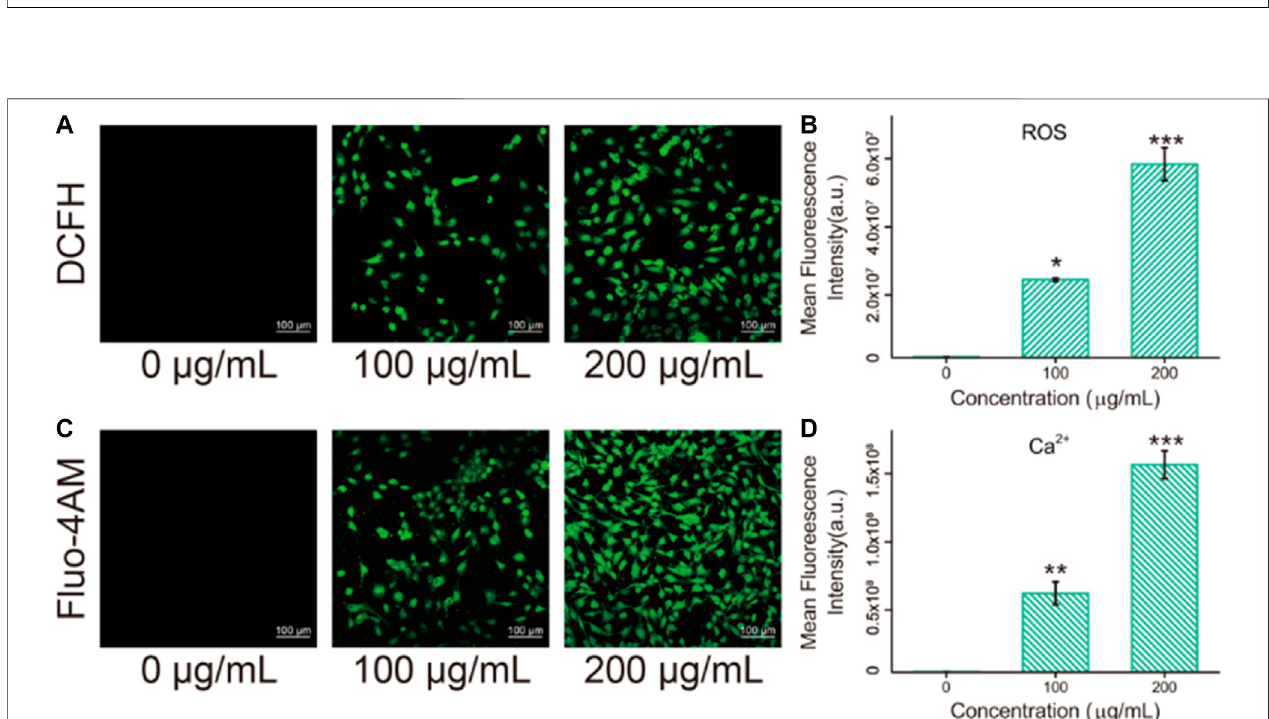
FIGURE 6 | (A) ROS levels in HBE cells were detected by DCFH after co-incubation with different concentration of Fe 3 O 4 /GO after 24 h (scale bar: 100 μ m). (B) Mean fl uorescence intensity of DCFH after co-incubation for 24 h. (C) Ca 2+ levels in HBE cells were detected by Fluo-4AM after co-incubation with different concentration of Fe 3 O 4 /GO after 24 h (scale bar: 100 μ m). (D) Mean fl uorescence intensity of Fluo-4AM after co-incubation for 24 h.